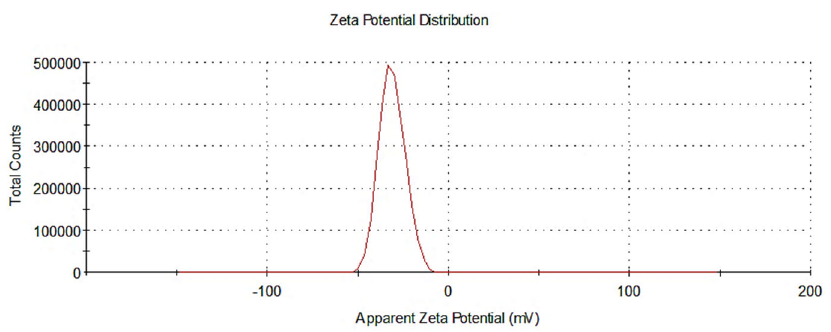
Figure 3. Distribution profile of zeta potential of the methotrexate-loaded TPGS-PLGA nanoparticles (nanoparticle formulation).